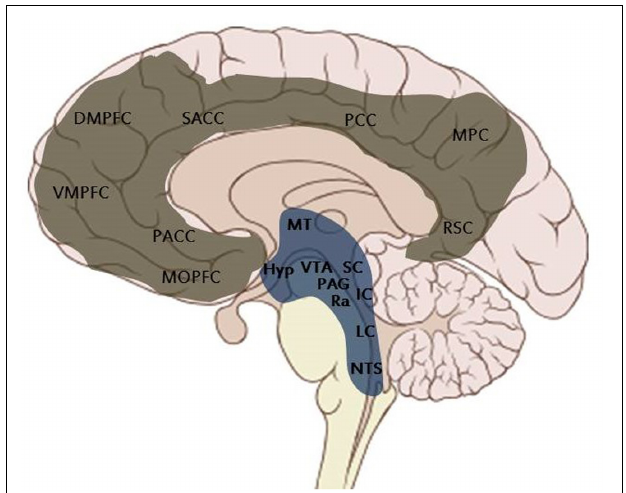
FIGURE 2 | Schematic illustration of the Midline Structures of the Brain. Subcortical midline structures (in blue): Hyp, hypothalamus; IC, inferior colliculus; LC, locus coeruleus; MT, mediodorsal thalmus; NTS, nucleus tractus solitaries; PAG, periacqueductal gray; Ra, raphe nuclei; SC, superior colliculus; VTA, ventral tegmental area. Cortical midline structures (in gray): DMPFC, dorsal medial prefrontal cortex; MOPFC, medial orbital prefrontal cortex; MPC, medial parietal cortex; PACC, pre- and subgenual anterior cingulate cortex; PCC, posterior cingulate cortex; RSC, retrosplenial cortex; SACC, supragenual anterior cingulate cortex; VMPFC, ventral medial prefrontal